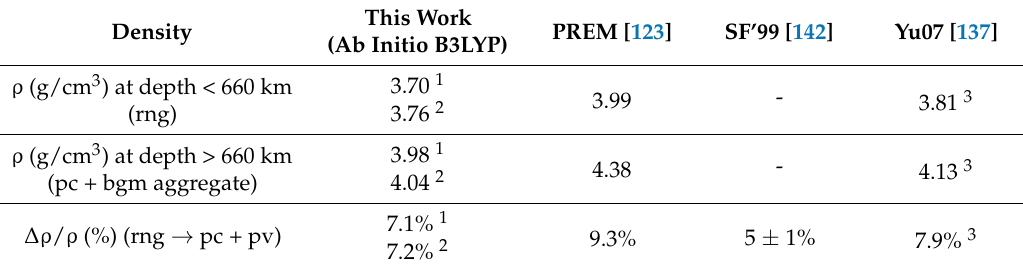
Table 6. Calculated density change ( ∆ ρ / ρ ; see Equation (20)) of the post-spinel phase transformation across the 660-km mantle seismic discontinuity, as compared to geophysical models [123,142]. The results of another DFT-GGA simulation [137] are also shown for comparison. Abbreviations for minerals are: rng = ringwoodite ( γ -Mg 2 SiO 4 ); pc = periclase (MgO); bgm = bridgmanite (MgSiO 3 ). This Work Density PREM [123] SF’99 [142] Yu07 [137] (Ab Initio B3LYP) 3.70 (rng)